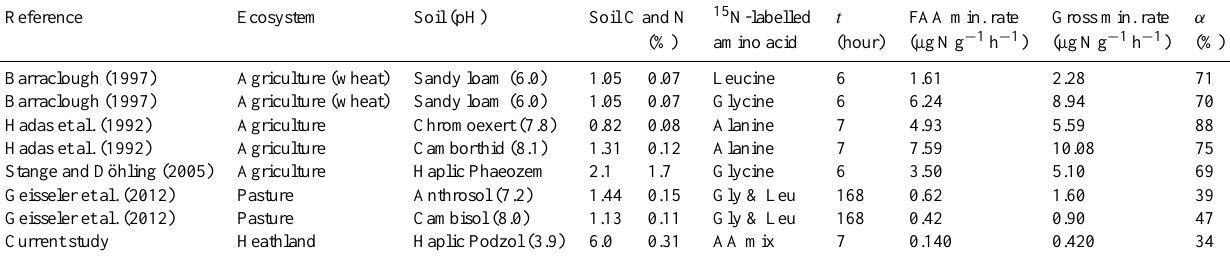
Table 3. Mirror 15 N labelling experiments in literature recording proportion of gross N mineralization directly from amino acids. Reference to paper, ecosystem type, soil type, pH (all in H 2 O), soil total C and N, type of amino acid label ( 15 N-enriched) in the experiment, incubation time, free amino acid mineralization rate, gross mineralization rate and proportion ( α ) of N mineralization from free amino